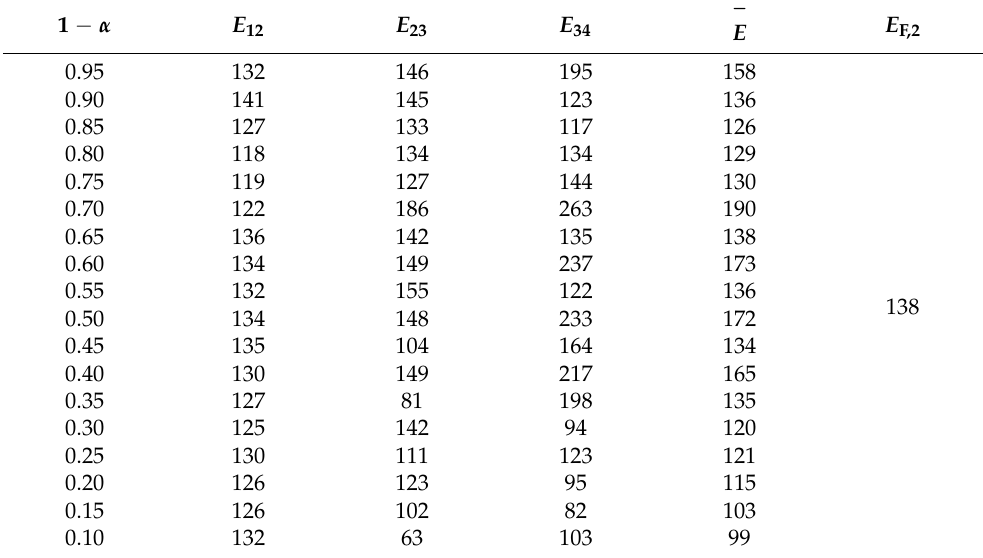
Table 6. The activation energy E F,2 of CYA decomposition from two-interval method (Unit: kJ/mol).